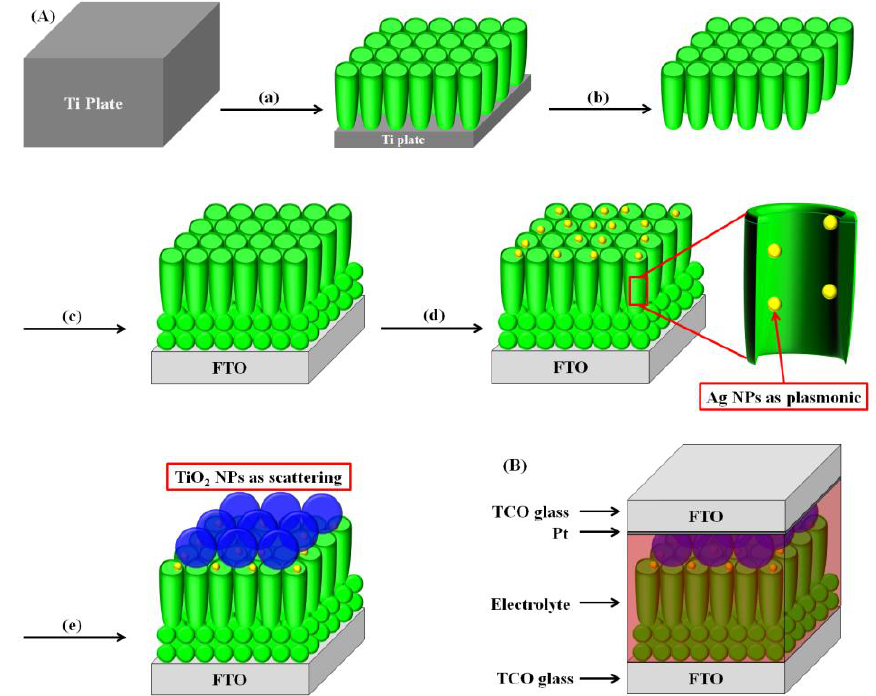
Figure 1. Overall scheme of dye-sensitized solar cells (DSSCs) with open-ended freestanding TiO 2 nanotube arrays with Ag nanoparticles (NPs) and large TiO 2 NPs. ( A ) (a) Ti anodization for TiO 2 nanotube arrays; (b) freestanding TiO 2 nanotube arrays and etching by ion milling; (c) transference of open-ended freestanding TiO 2 nanotube arrays onto fluorine-doped tin oxide (FTO) glass; (d) formation of Ag NPs by ultraviolet (UV) irradiation; and (e) introduction of large TiO 2 NPs. ( B ) Structure of a DSSC with freestanding TiO 2 nanotube arrays and large TiO 2 NPs.